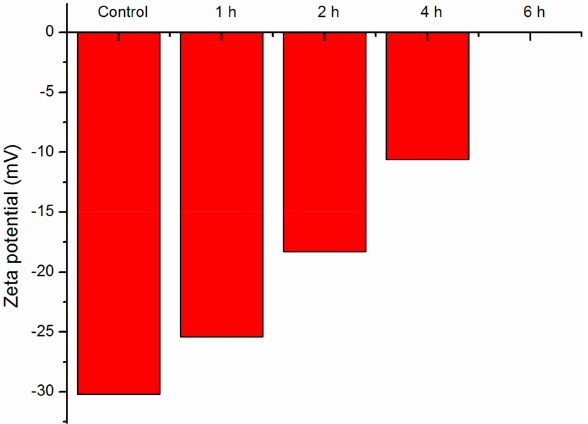
Figure 5. Zeta potential of M. aeruginosa cells after nano-TiO 2 mediated